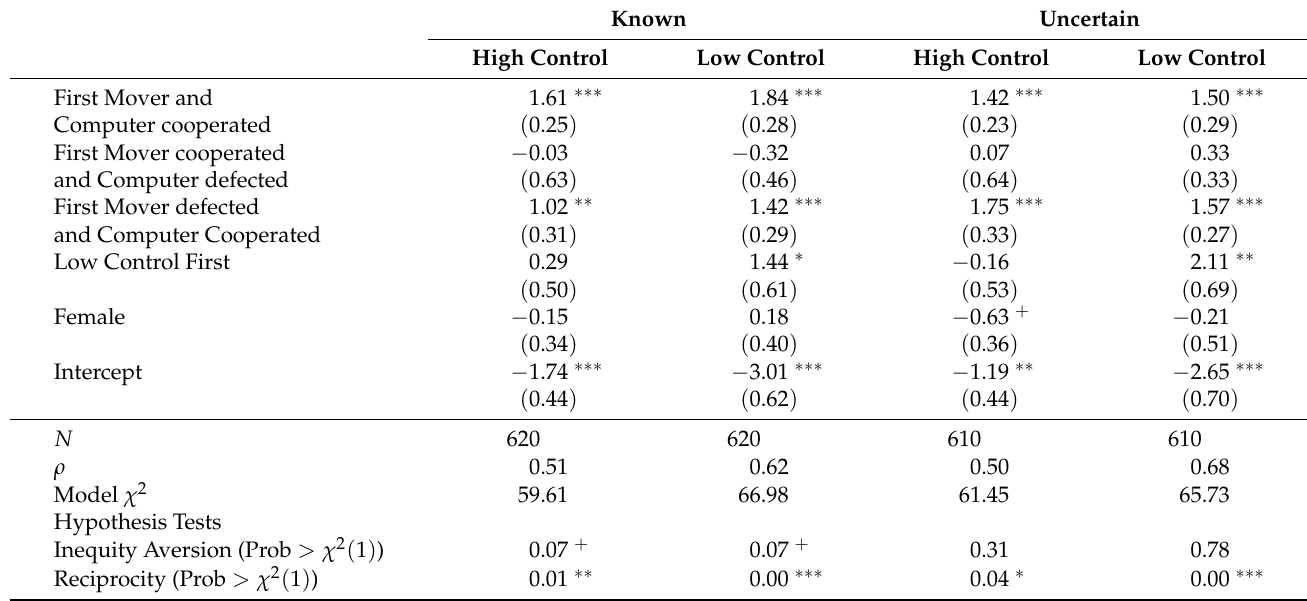
Table 3. Second Mover Cooperation by